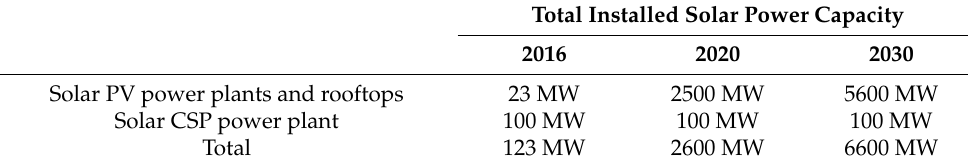
Table 3. The total installed capacity of solar